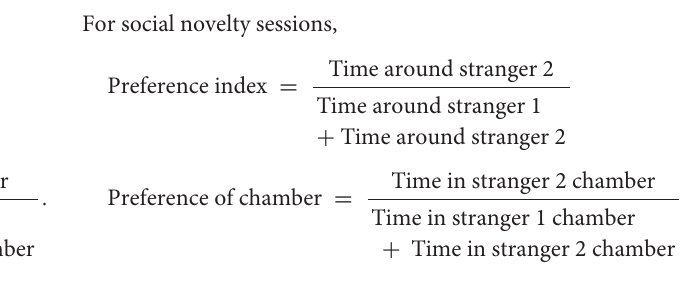
For sociability